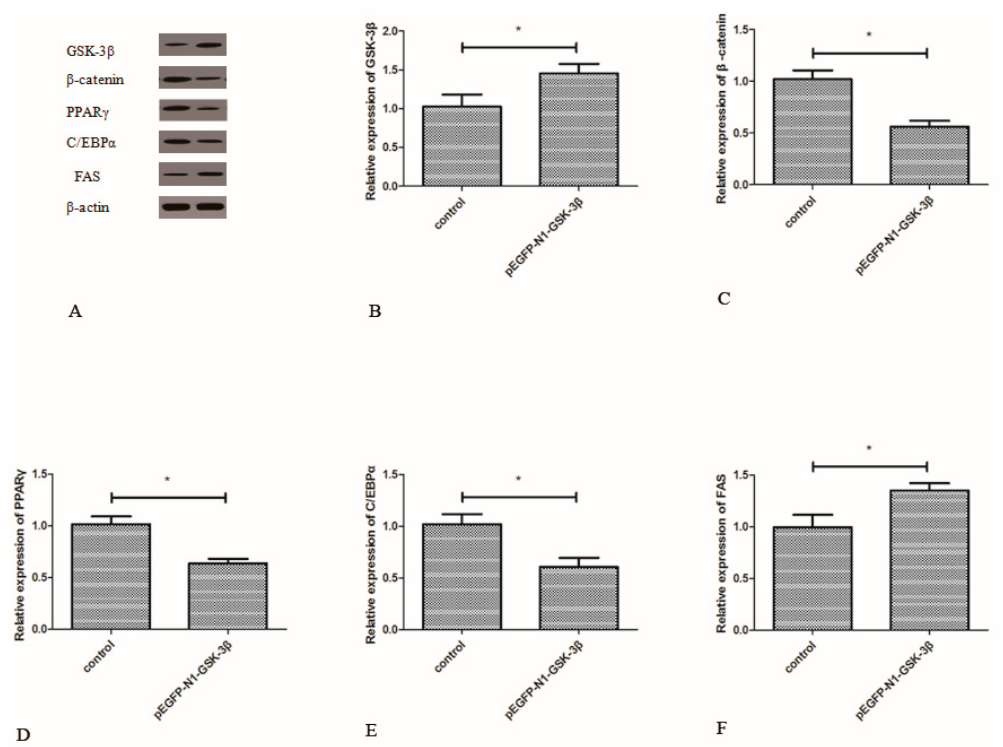
Figure 5. Effect of the pEGFP-N1-GSK-3 β vector on the protein expression of GSK-3 β , β -catenin, PPAR γ , C/EBP α , and FAS in the muscle of zebrafish. ( A ) The protein bands; ( B ) GSK-3 β ; ( C ) β -catenin; ( D ) PPAR γ ; ( E ) C/EBP α ; ( F ) FAS. Values are expressed as means ± s.e.m. ( n = 6). Statistically significant differences are denoted by asterisk ( p < 0.05).